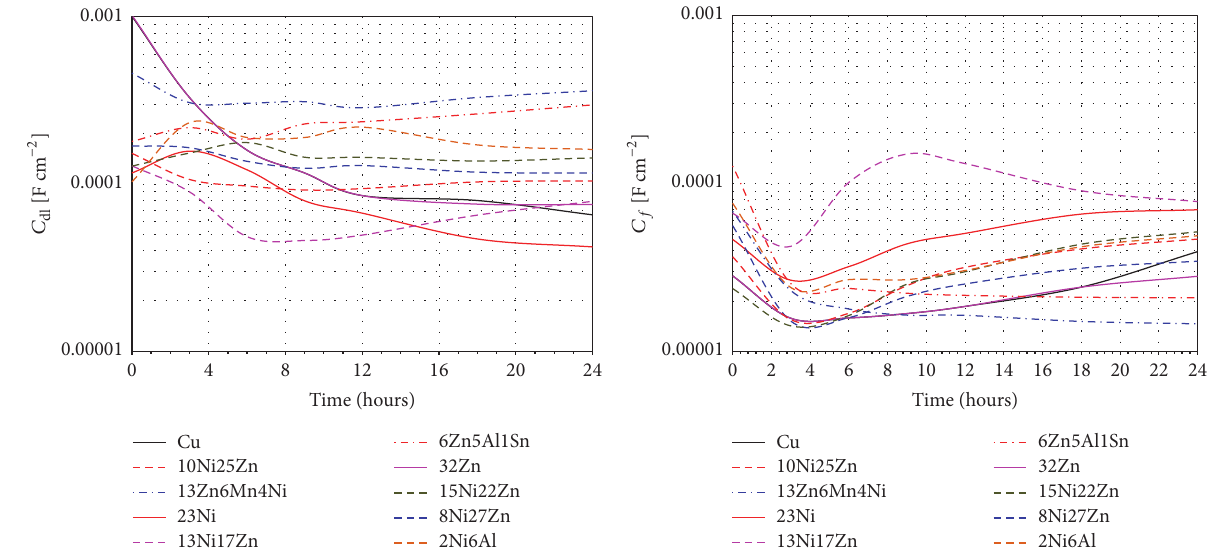
Figure 10: 𝐶 dl and 𝐶 𝑓 variation against time for Cu-based coins evaluated in artificial sweat at 37 ∘ C.